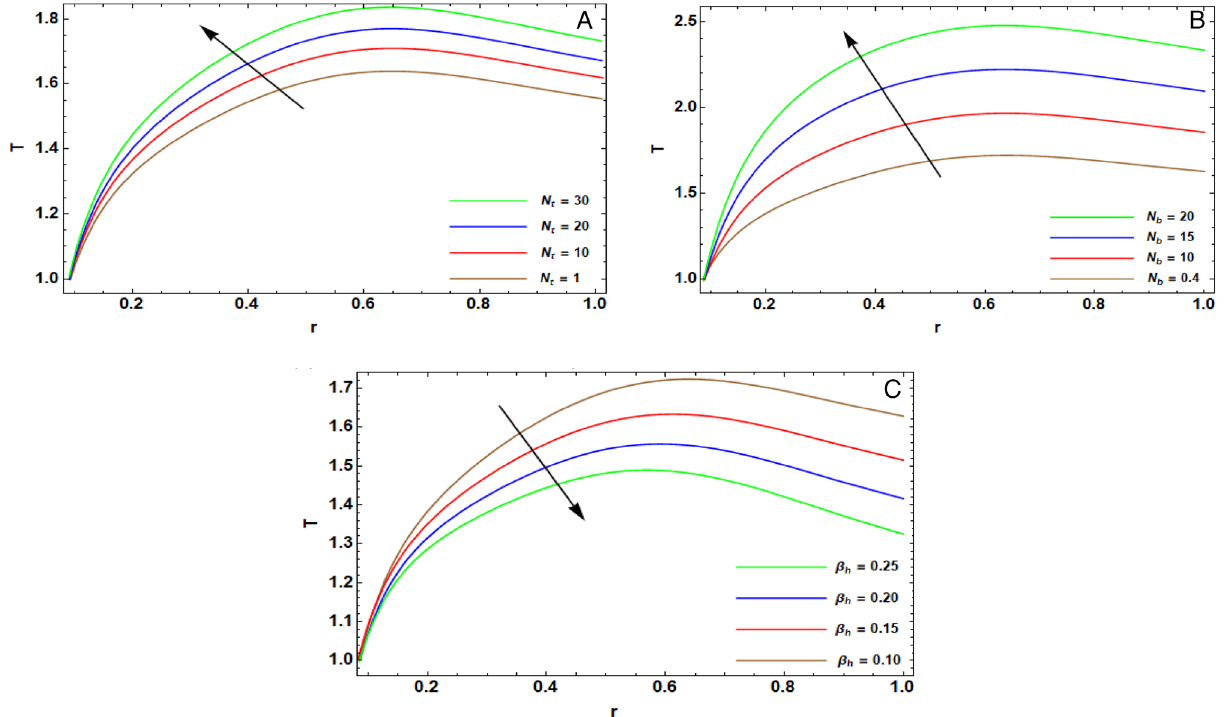
Figure 4. ( A ) implies alteration T ( r ) for diverse amounts of N t . ( B ) implies alteration T ( r ) for diverse amounts of N b . ( C ) implies alteration T ( r ) for diverse amounts of β h